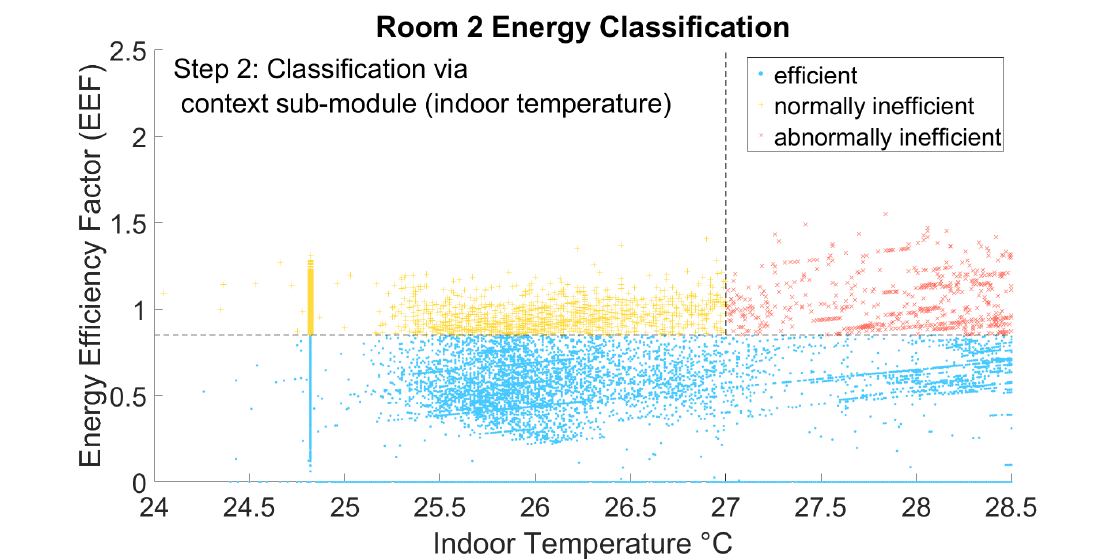
Figure 7. Classification of normal and abnormal behavior based on inference rules in the context sub-module for